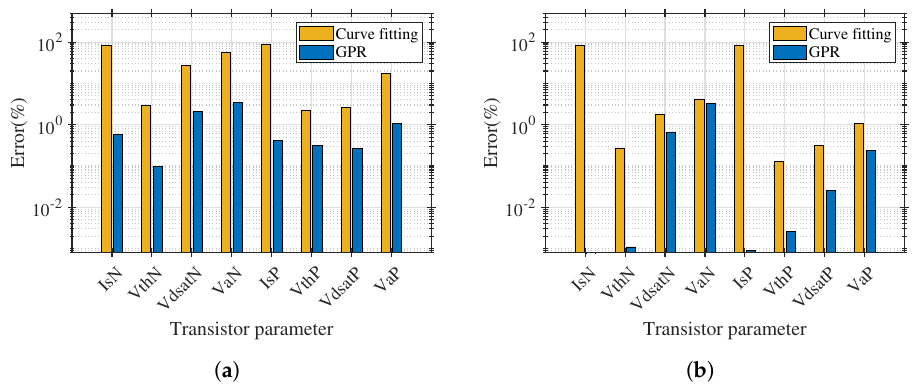
Figure 4. Comparison of the percentage error of prediction of CMOS parameters using models based on curve-fitting and Gaussian process regression (GPR) for sizes ( a ) KL = 1, KWL = 4. ( b ) KL = 10, KWL = 50. These models were built from the characterization